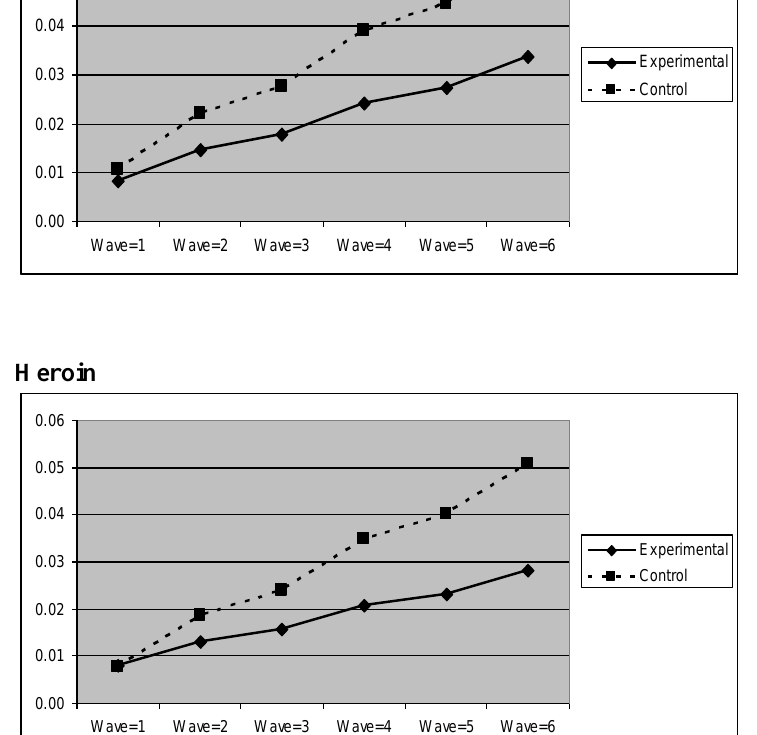
FIGURE 15 . Growth trajectories of the experimental group (Tier 1 participants who perceived the program as effective) and control group using the item score of heroin use as the outcome